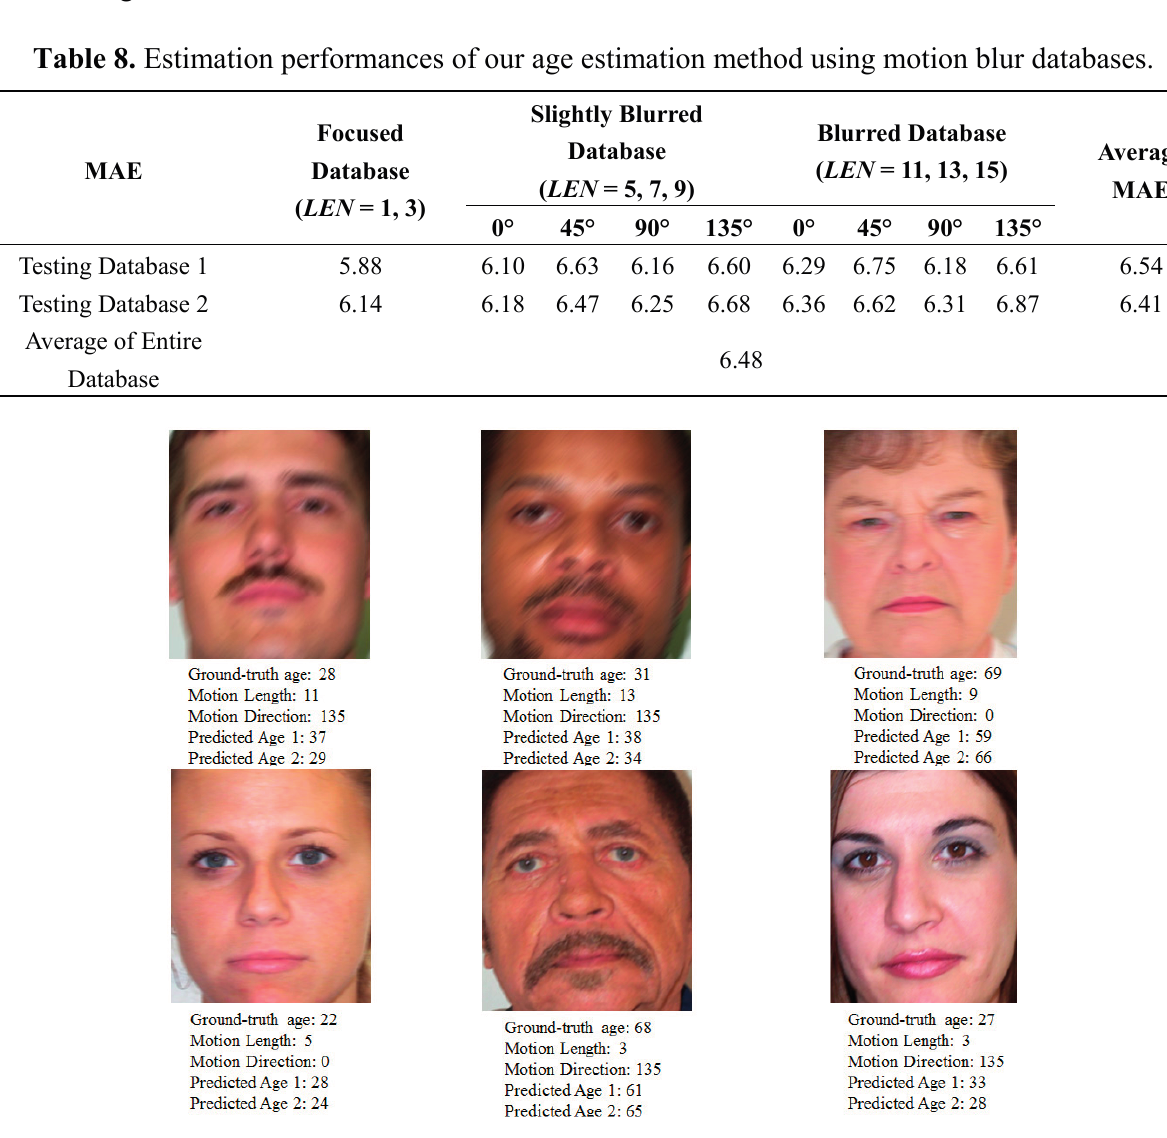
Figure 18. Sample results of estimation process with and without our